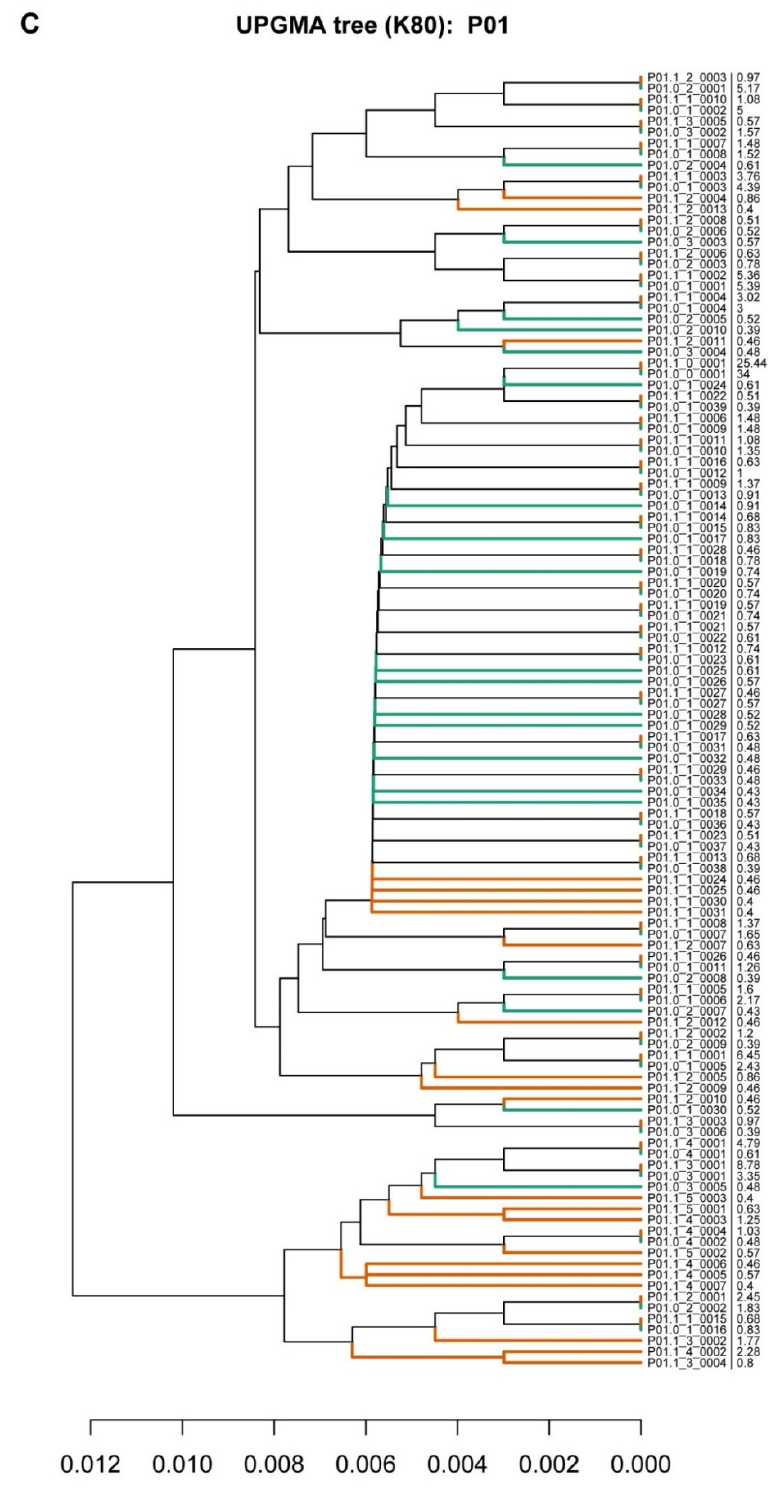
Figure 1. Phylogenetic trees representing the liver quasispecies population before (pre-LT) and after (post-LT) liver transplantation. Haplotypes from the pre-LT quasispecies are represented in green, and haplotypes from the post-LT quasispecies are in orange, as examples of the three infection patterns found. ( A ) Patient 05; ( B ) Patient 08; ( C ) Patient 01. The nomenclature used was Pxx.y_z_vvvv, where xx is the patient identifier (P01, P02 etc), y is the sample identifier (0 for pre-LT, 1 for post-LT), z is the number of differences between the haplotype and the master sequence, and vvvv is an identifier for haplotypes with the same number of mutations in the quasispecies. The last percent number represents the frequency at which each haplotype is represented in the quasispecies.